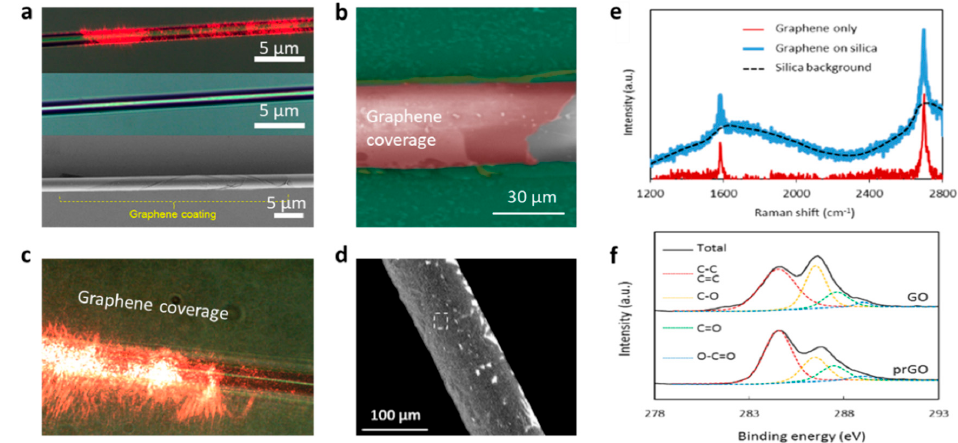
Figure 7. Characterizations of graphene-based microfiber structures. ( a ) Visible scattering, optical microscope, and SEM pictures of a graphene-wrapped hot drawn microfiber. ( b ) A false-colored SEM picture of a graphene-wrapped microfiber etched chemically. ( c ) Light scattering enhancement due to the graphene. ( d ) SEM of an etched microfiber covered by reduced GO. ( e ) Raman spectra. ( f ) Measured X-ray photoelectron spectroscopy (XPS) results. Here figures ( a – d ) are reproduced from Refs. [45,46,74,76], respectively.